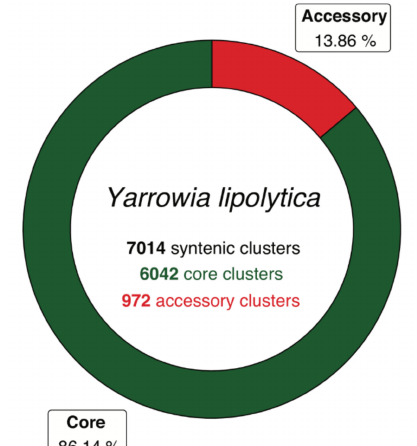
Figure 2. Pan-genome of Yarrowia lipolytica represented as a ring chart of proportions of core and accessory ortholog clusters within the total dataset. Modified from original figure generated by Pangloss. Core proportions coloured in green, accessory proportions coloured in red.